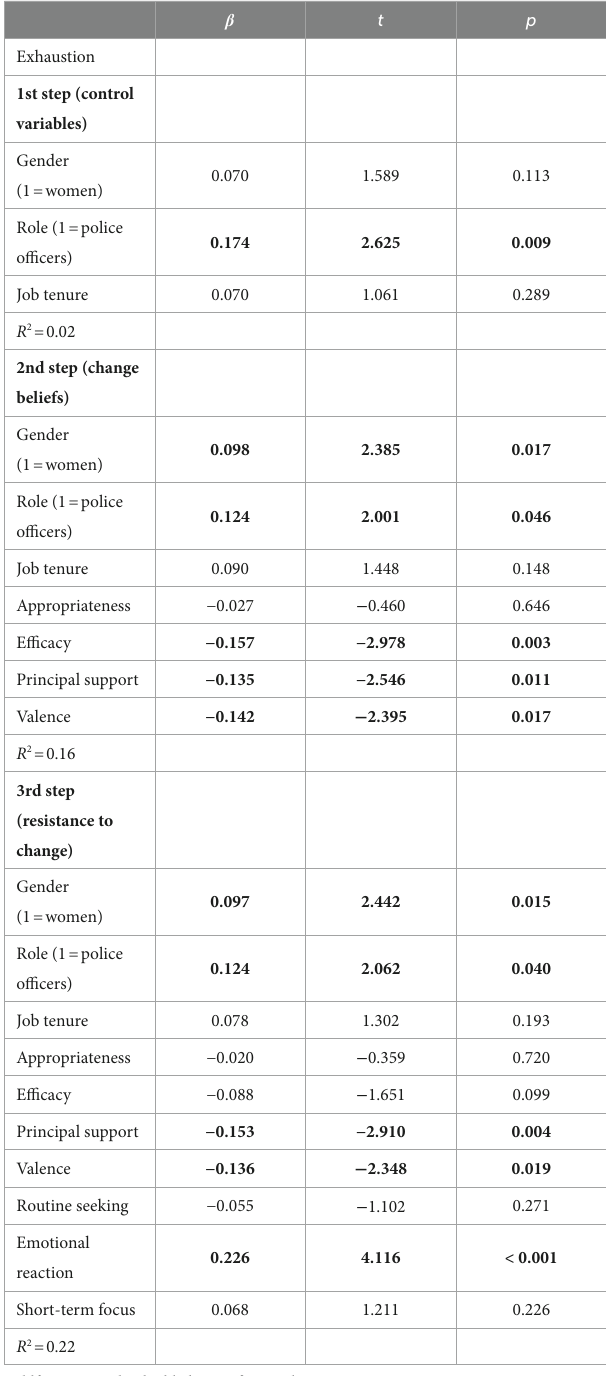
TABLE 4 Hierarchical multiple regression (exhaustion = dependent